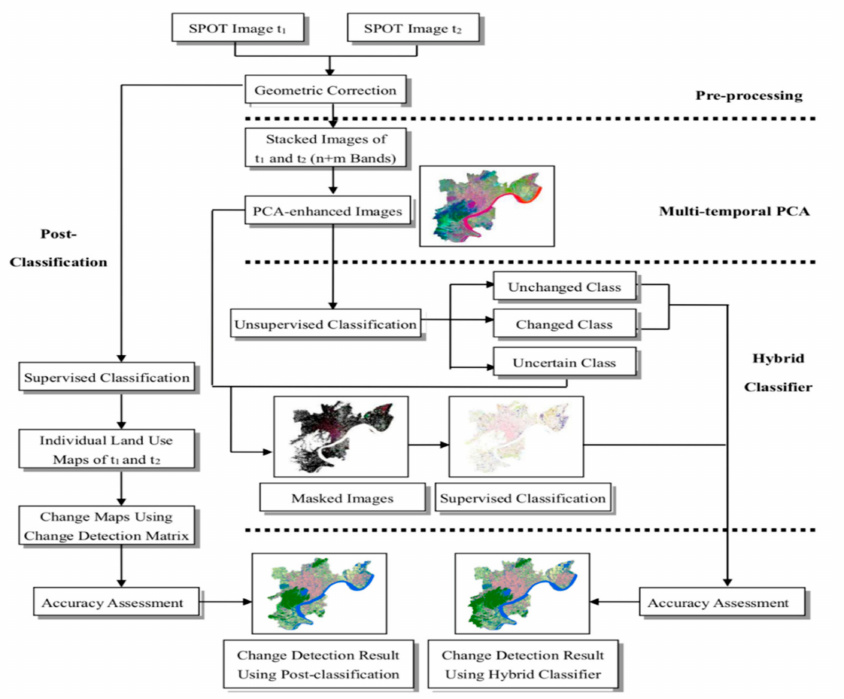
Figure 2. The flowchart of the proposed methodology and post-classification comparison change